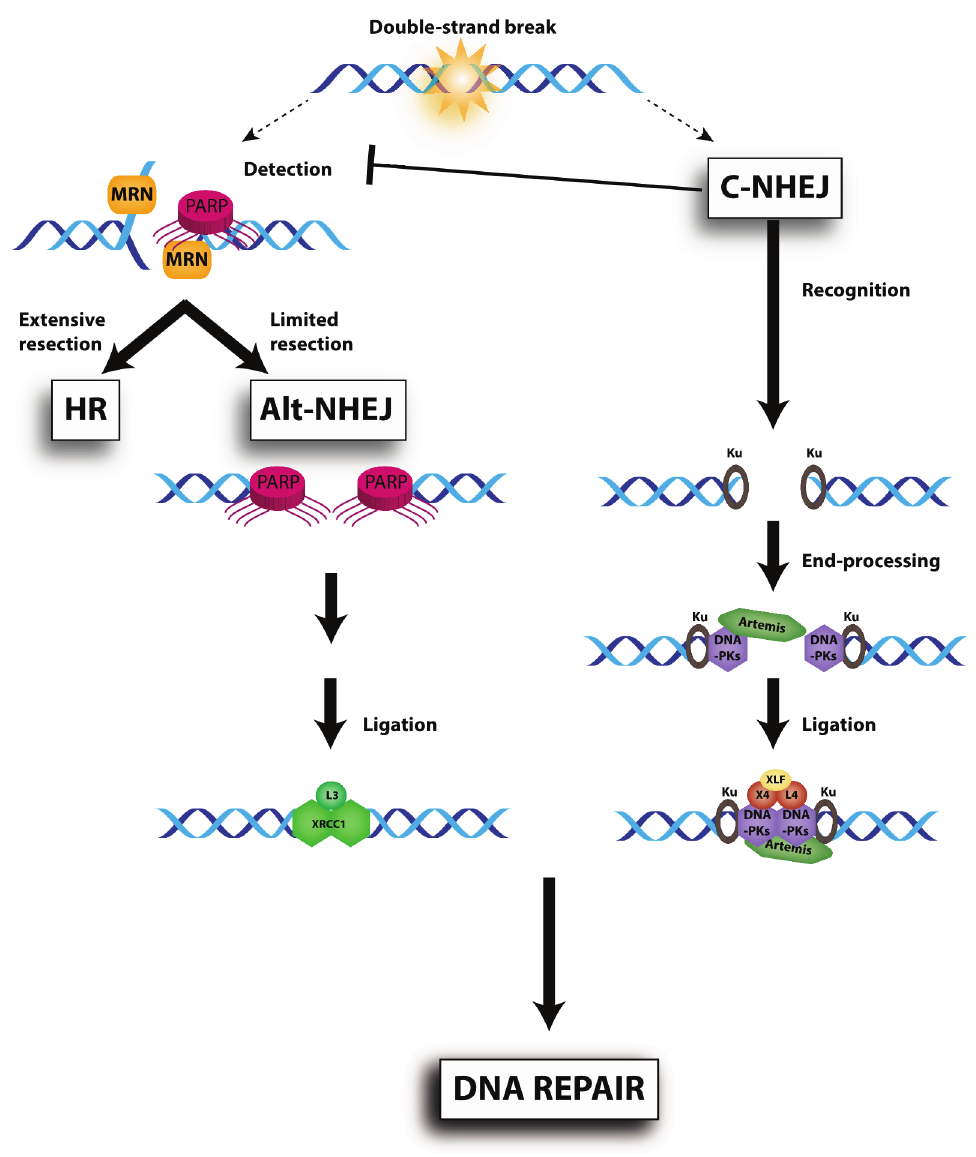
Figure 3. Schematic representation of DNA repair by non-homologous end-joining (NHEJ): classical NHEJ (C-NHEJ) or alternative NHEJ